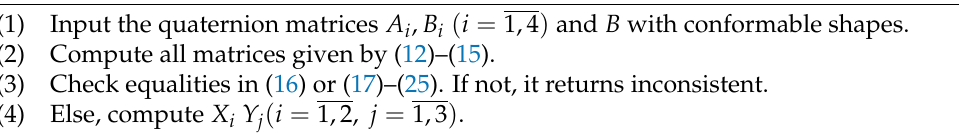
Algorithm 1 Algorithm for computing the general solution of Equation